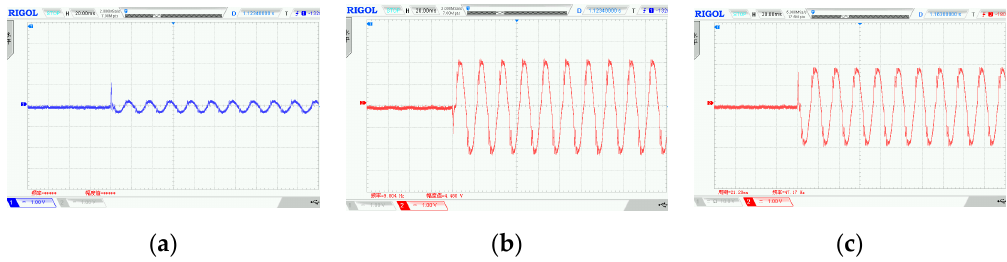
Figure 17. Experimental results of zero-sequence currents when a single-phase earth fault occurs on the end of the second feeder: ( a ) first feeder; ( b ) second feeder; and ( c ) third feeder.